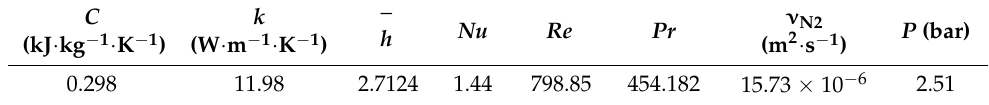
Figure 2. The meshed structure of a biofuel pellet. Table 3. The thermo-fluid parameters for a biofuel pellet.